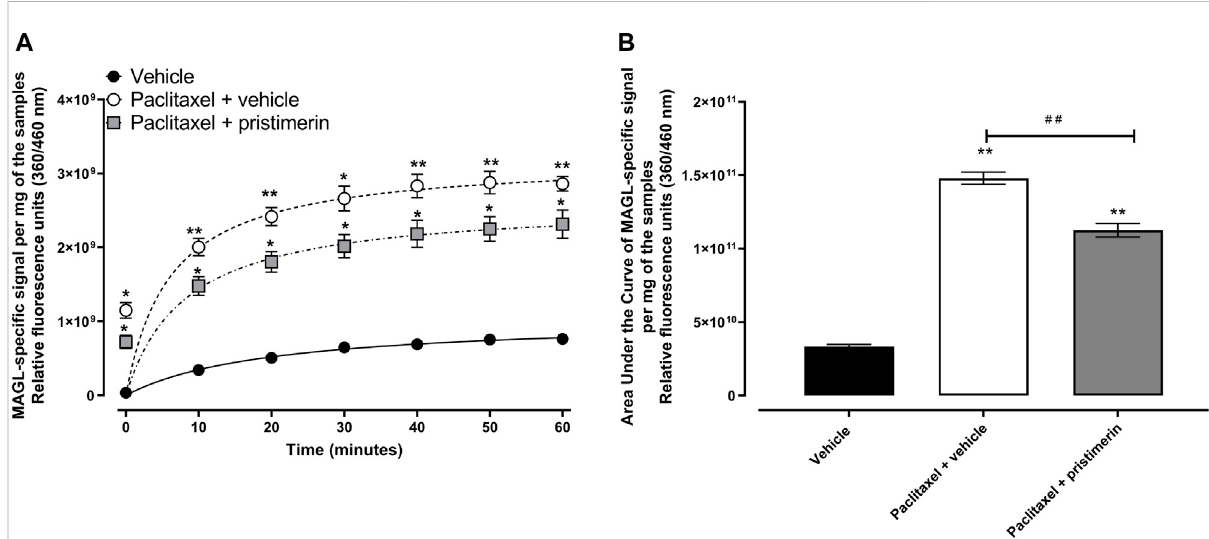
FIGURE 6 Pristimerin prevents the paclitaxel-induced increase in MAGL activity in the paw skin of female BALB/c mice. (A) Relative fl uorescence units (360/460 nm) over time as a product of MAGL-speci fi c signal per mg of the paw skin samples from vehicle-, paclitaxel plus vehicle- and paclitaxel plus pristimerin-treated mice at day 7 post- fi rst injection (dpi) of paclitaxel. Each symbol represents the mean ± SEM of values obtained from 3 experiments from samples pooled from 4 animals. * p < 0.05, ** p < 0.01 compared to mice treated with vehicle only (two-way repeated measures ANOVA followed by Tukey ’ s multiple comparisons test). (B) Area under the curve of relative fl uorescence of MAGL-speci fi c signal per mg of the paw skin samples from vehicle-, paclitaxel plus vehicle- and paclitaxel plus pristimerin-treated mice at day 7 dpi of paclitaxel. Each symbol represents the mean ± SEM of values obtained from 3 experiments from samples pooled from 4 animals. ** p < 0.01 compared to mice treated with vehicle only and ## p < 0.01 compared to mice treated with paclitaxel + vehicle (one-way ANOVA followed by Tukey ’ s multiple comparisons